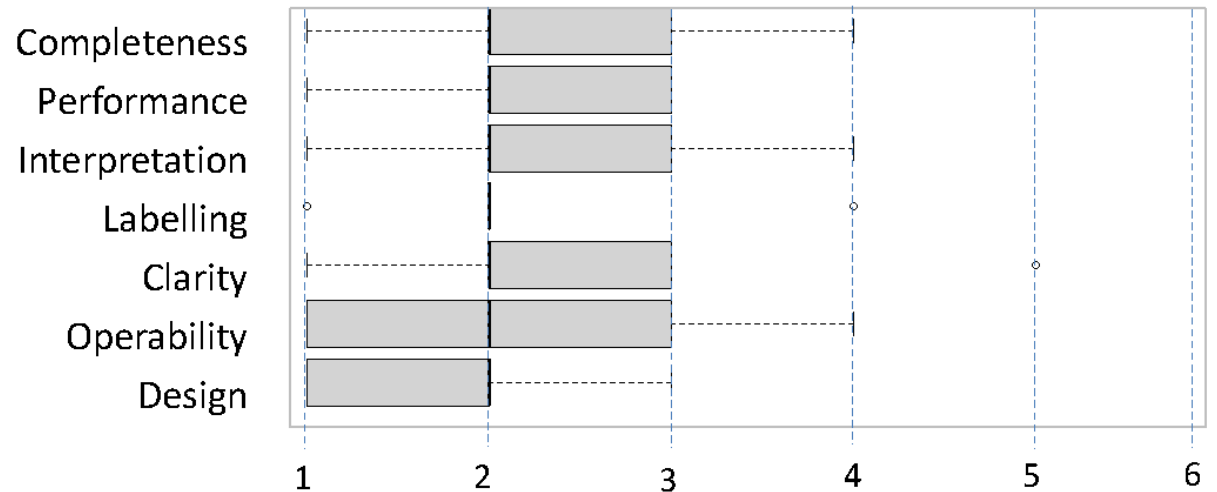
Figure 8. Overall rating of usabililty aspects (Rating scale: 1 = “Very good” to 6 =